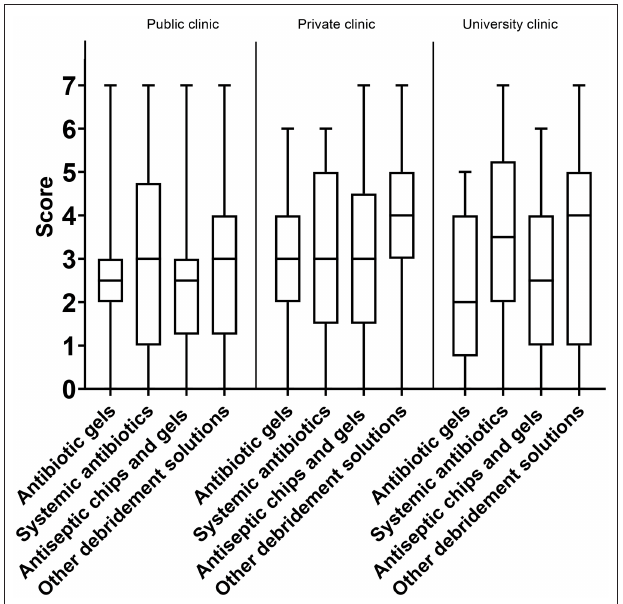
FIGURE 7 | Box-plot with score of predictability of chemical remedies segmented by responder’s workplace.